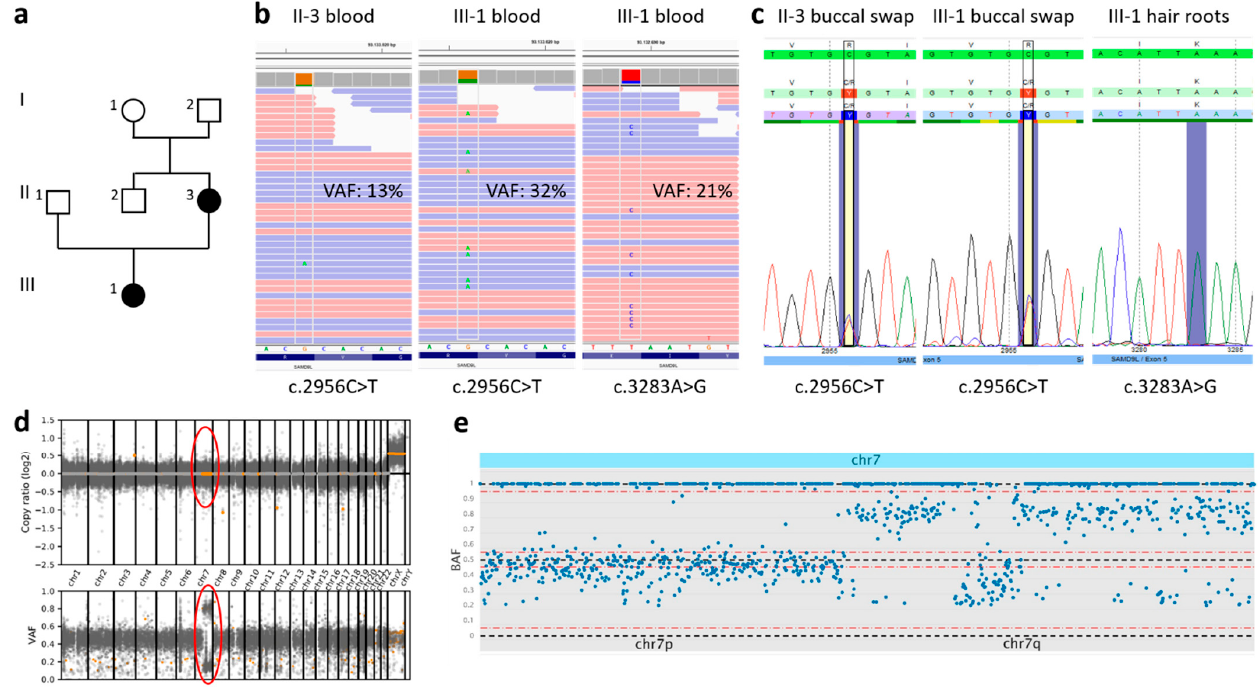
Figure 2. ( a ) Family tree. ( b ) Whole-exome sequencing of DNA extracted from peripheral blood of mother (II-3) and daughter (III-1) showing mosaicism for the variant c.2956C>T; p.(Arg986Cys) with a variant allele frequency (VAF) of 13% (II-3) and 32% (III-1), respectively. The daughter additionally carried a rare somatic missense variant c.3283A>G; p.(Lys1095Glu) with a VAF of 21%. The variant c.2956C>T was not present in the grandparents I-1 and I-2 in leukocyte-derived DNA in exome sequencing data. ( c ) Sanger sequencing of DNA extracted from different tissues of II-3 and III-1 confirmed the germline status of the variant c.2956C>T and somatic status of the variant c.3283A>G. ( d ) Genome wide scatter plot illustration with the detection of UPD7q of the mother (circles). ( e ) A scatter plot (generated by SNPitty) of the b-allele frequency from chr 7 of II-2 showed copy number neutral loss of heterozygosity of 7q caused by stretches of isodisomic uniparental disomy (UPD). UPD7q correlated with a concordant decrease in the variant allele frequency of the SAMD9L variant, evident in both WES and Sanger sequencing data.